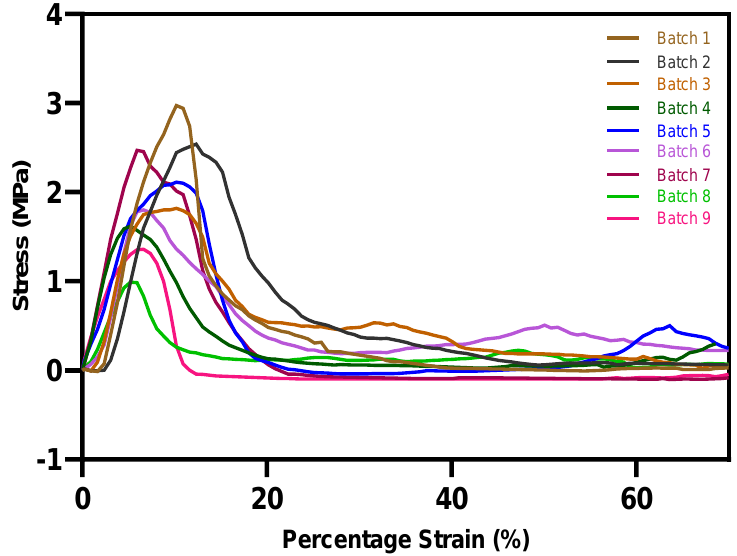
Figure 12. Stress–strain curves of interfacial strength test for all batches of overprinted tablets. Batch 1: 45 ◦ / − 45 ◦ ; Batch 2: 60 ◦ / − 60 ◦ ; Batch 3: 75 ◦ / − 75 ◦ ; Batch 4: 60 bar; Batch 5: 120 bar; Batch 6: 50% infill; Batch 7: 100% infill; Batch 8: 25% infill, no solid layers; Batch 9: 50% infill, no solid layers.